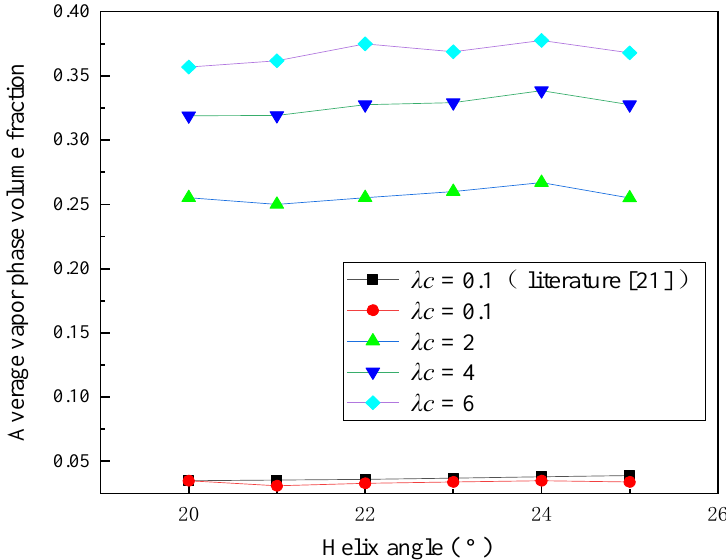
Figure 3. Variation of average vapor volume fraction with helix angle under different mass trans- fer